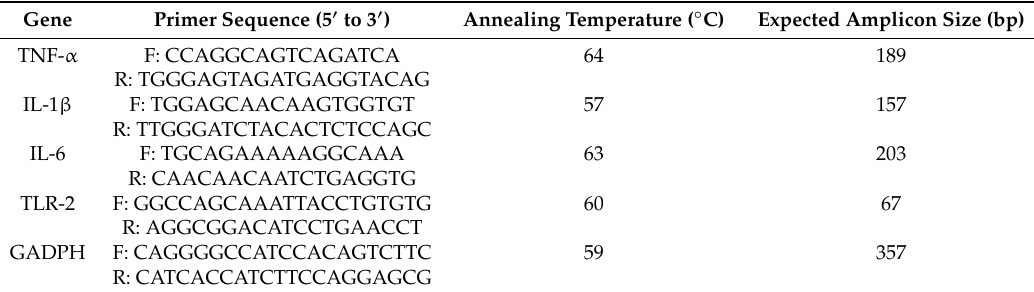
Table 1. Primers used in the second stage qrt-PCR